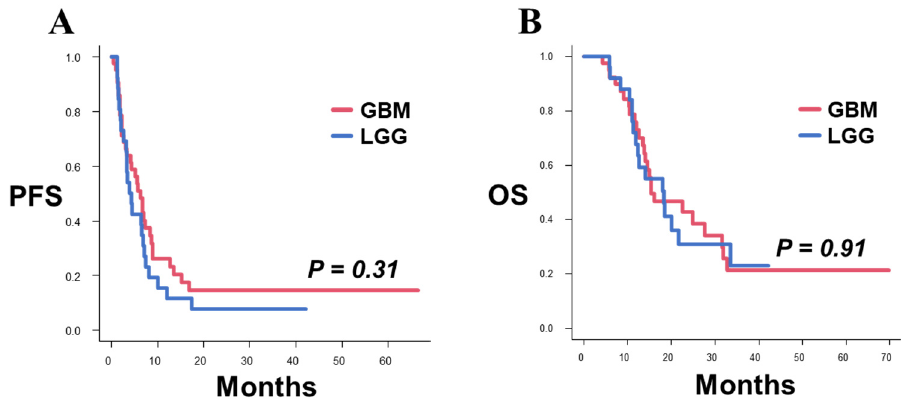
Figure 2. Kaplan–Meier survival curves for PFS and OS after surgery for recurrence in the GBM and LGG groups. ( A ) The PFS was not significantly different between the GBM and LGG groups (median PFS: GBM 6.3 months, LGG 4.2 months; p = 0.31). ( B ) The OS was not significantly different between the GBM and LGG groups (median OS: GBM 15.4 months, LGG 18.3 months; p = 0.91). Table 2. Univariate and multivariate analyses for PFS.